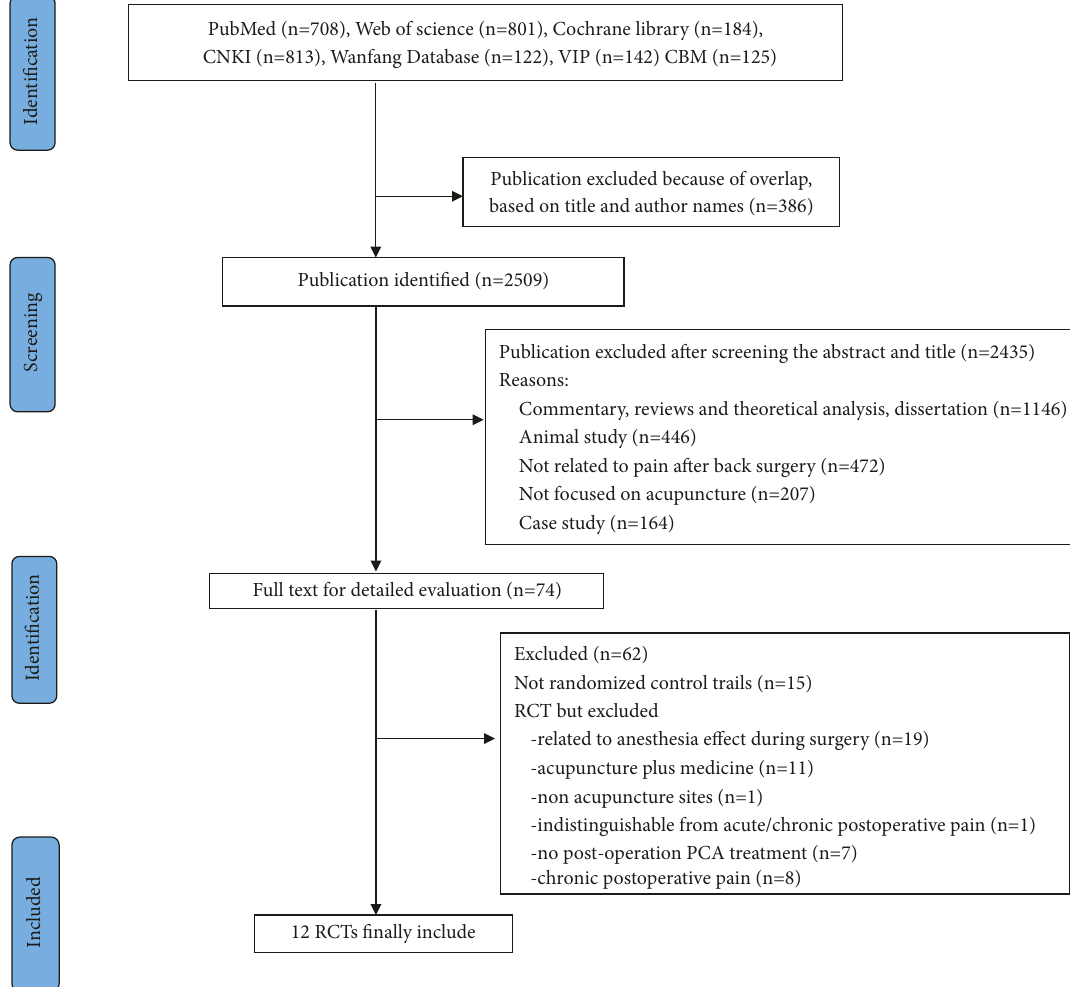
Figure 1: Literature screening flow